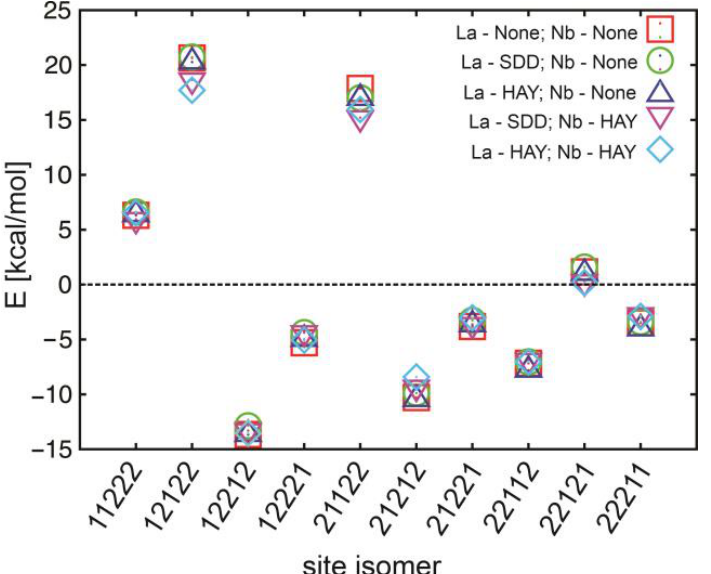
Figure 9. Relative energies of the ten LNT occupational isomers calculated with the B3LYP func- tional and with various pseudopotentials and basis sets (Table 3, rows 1–5). For each set of calculations, the zero value corresponds to the energy average of all isomers in that set.